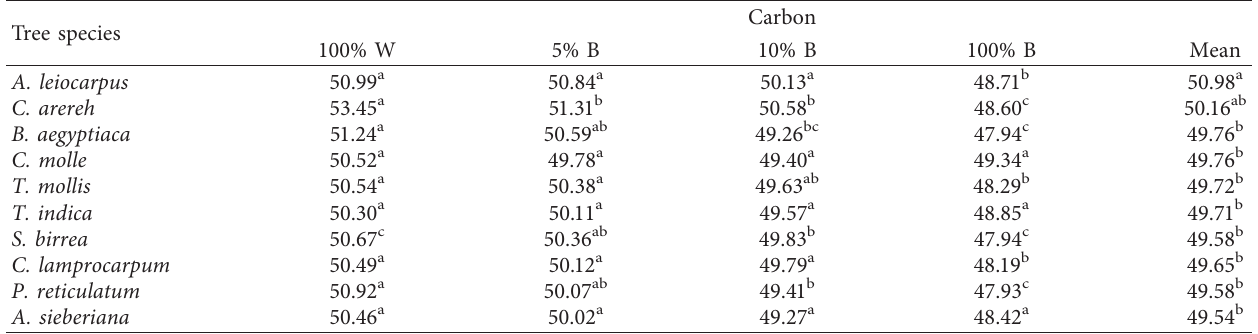
Table 1: Effect of bark inclusion on the carbon contents (%) of selected fuelwood species. Tree